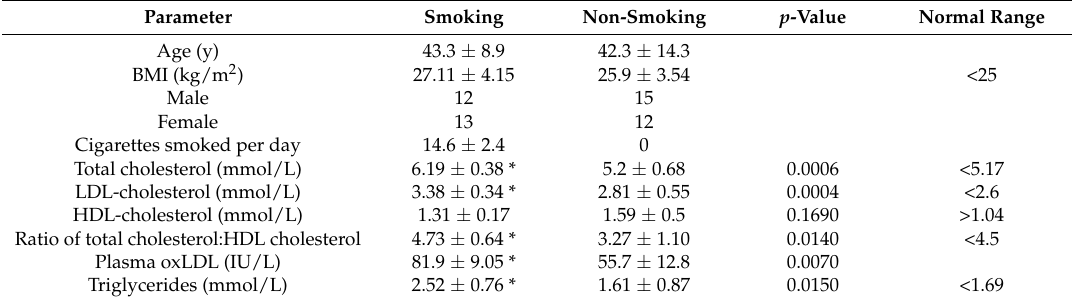
Table 1. Clinical and biochemical profiles of the smoking and non-smoking groups ( n = 52 ± SD). * indicates significant differences ( p < 0.05) between the smoking and non-smoking cohorts.